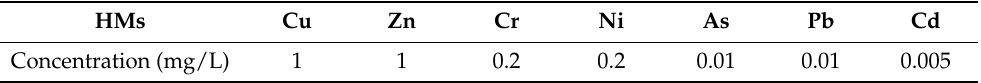
Table 4. The concentration of metals according to the class III groundwater